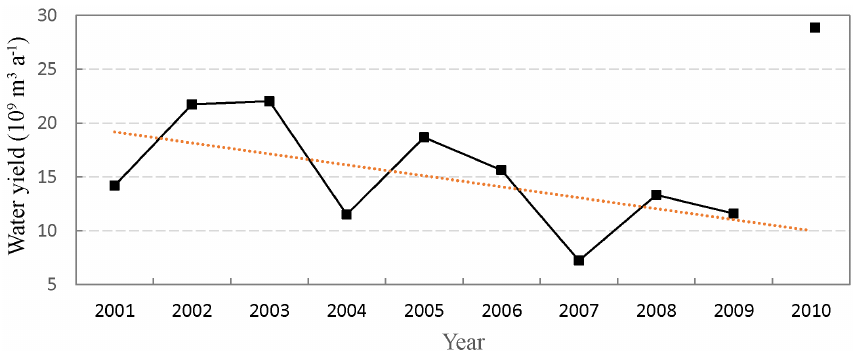
Figure 8. The variation trend of the annual water yield of the ungauged zone from 2001 to 2009. It shows declining trend at a rate − 1.02billionm 3 a − 1 ( P < 0.05).